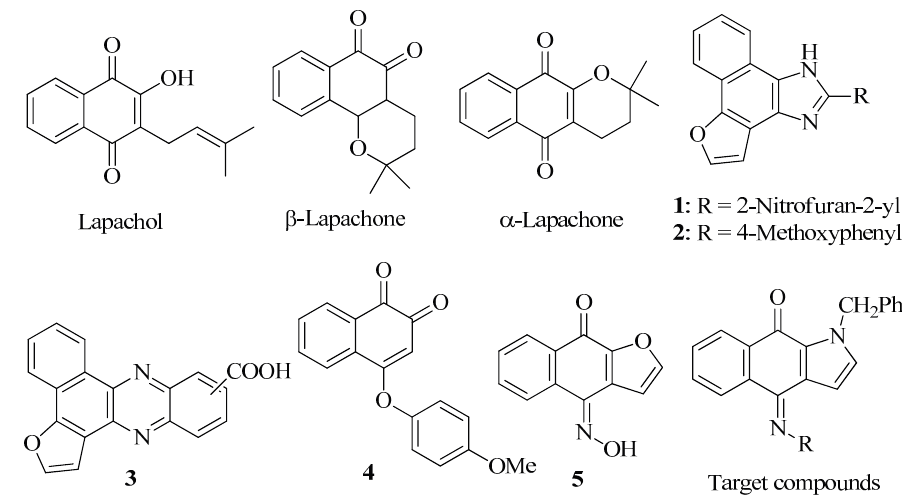
Figure 1. Structures of lapachol, β -lapachone, α -lapachone, and compounds 1 – 5